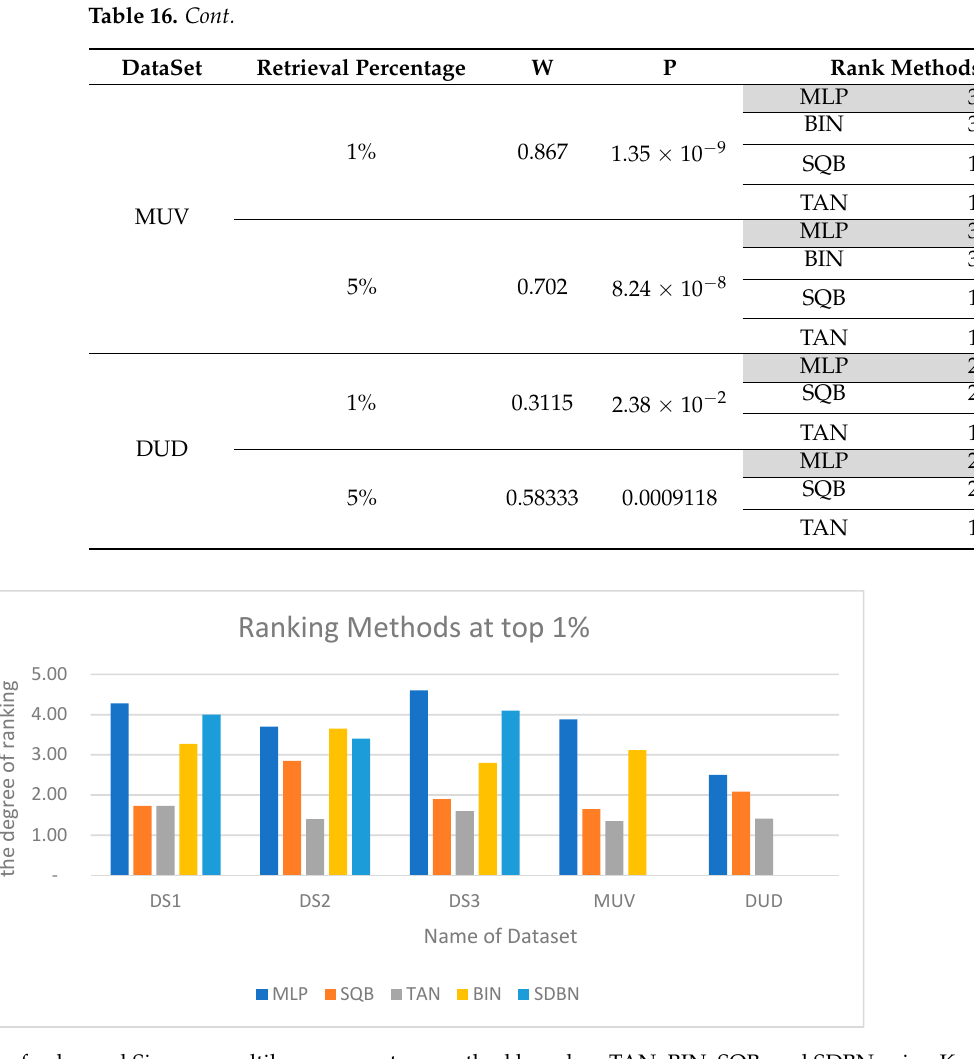
Figure 14. Ranking of enhanced Siamese multilayer perceptron method based on TAN, BIN, SQB, and SDBN using Kendall W test results for DS1, DS2, DS3, MUV, and DUD at top 1%.